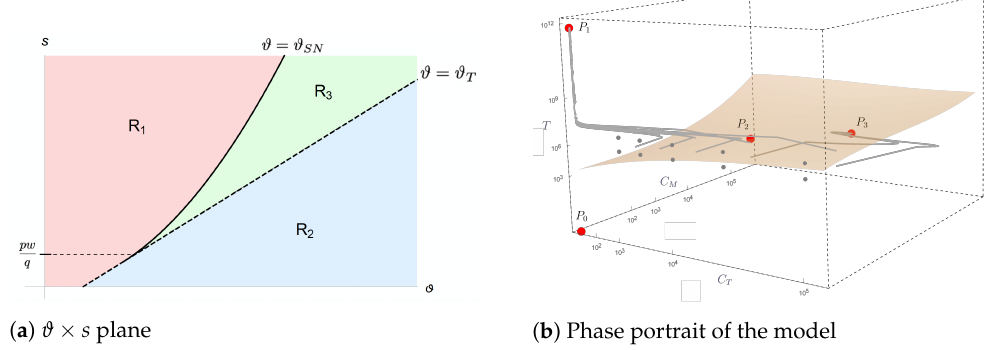
Figure 2. The CAR-T therapy ODE model presents different dynamical behaviors in each of the s plane ( a ). In the HDLM-2 + CAR-T 123 scenario, three regions R 1 , R 2 , and R 3 , indicated in the ϑ × the parameter values correspond to region R 3 , and the phase portrait in this case together with typical model trajectories are shown in ( b ). The equilibrium points are indicated by red dots. The yellowish surface represents the separatrix between the basins of attraction of P 1 (escape) and P 3 (stable coexistence). The saddle points are indicated by P 0 and P 2